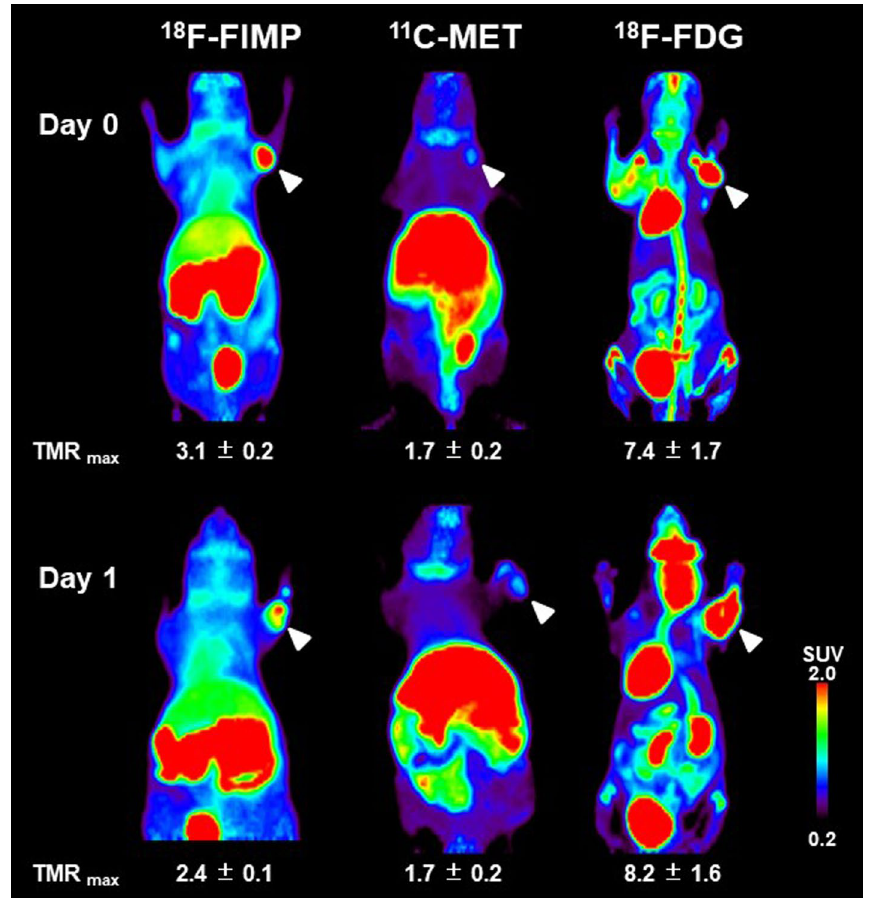
Figure 7. PET probe accumulation in LNZ308 tumors after irradiation. Images shown are the maximum intensity projection (MIP) image of [ 18 F]FIMP, [ 11 C]MET, and [ 18 F]FDG-PET after irradiation on days 0 and 1. Tumors on right paws, as indicated by arrows, were irradiated on day 0 at the dose of 60 Gy. PET data were acquired 90 min after injection of [ 18 F]FIMP and [ 11 C]MET. [ 18 F]FDG-PET data was acquired 55 to 100 min after injection. Data were reconstructed using OS-EM algorithm. Part of this figure was sourced from the following paper. Sci Rep. 2019 Oct 31;9(1):15718. https:// doi. org/ 10. 1038/ s41598- 019-